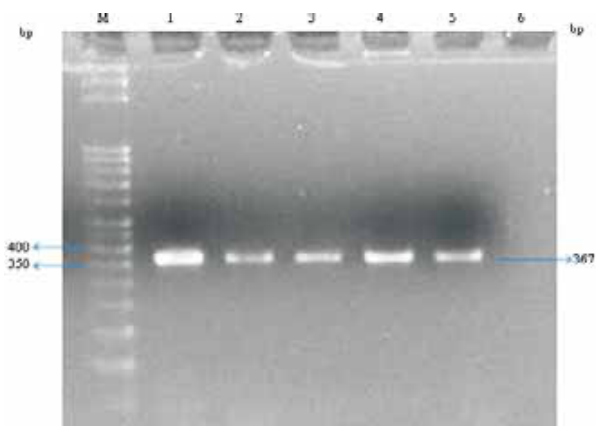
Figure-1: Agarose gel electrophoresis of the PCR amplified Lane M: 50 bp DNA ladder, Lanes 1 fragment of gene. CD18 to 5: PCR product specific to a fragment of 5 exon of